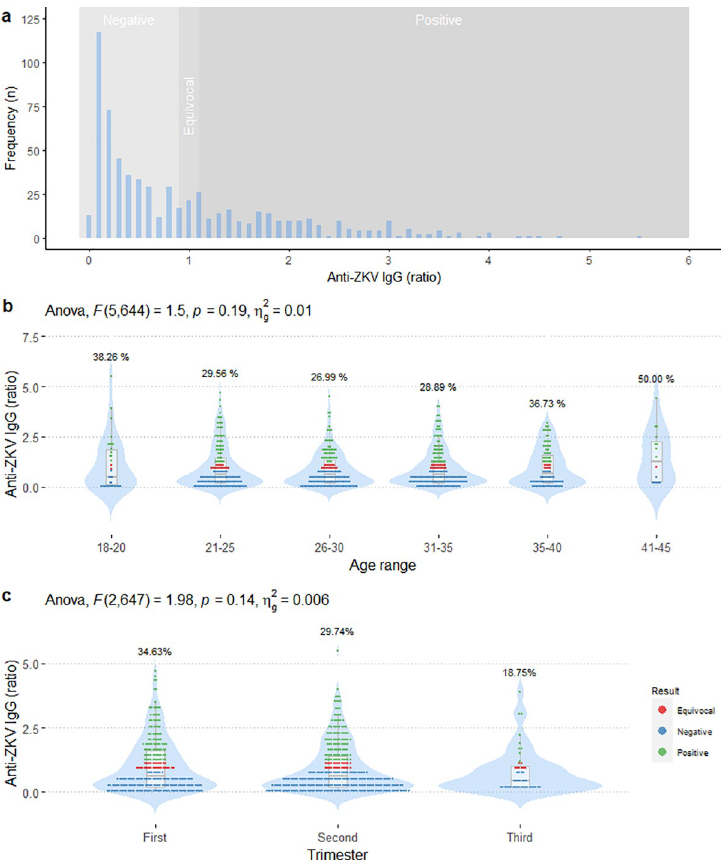
Fig 1. The Zika virus-specific IgG in pregnant women. The distribution of Zika virus-specific IgG in pregnant women (a). ZKV-specific IgG by age range (b) or trimester (c).